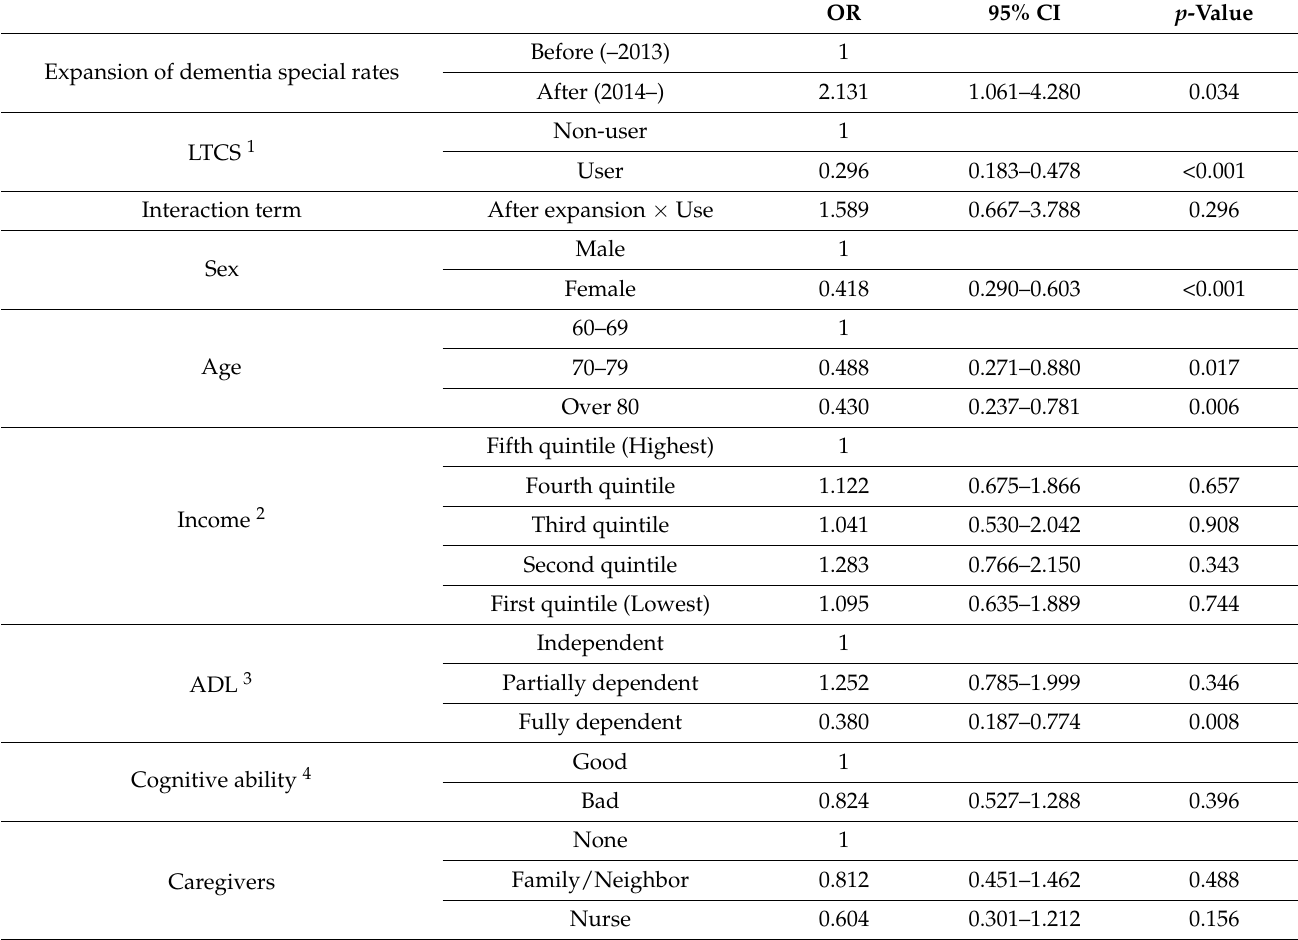
Table 3. DID analysis of expansion of LTCS with dementia special rates. OR 95% CI p